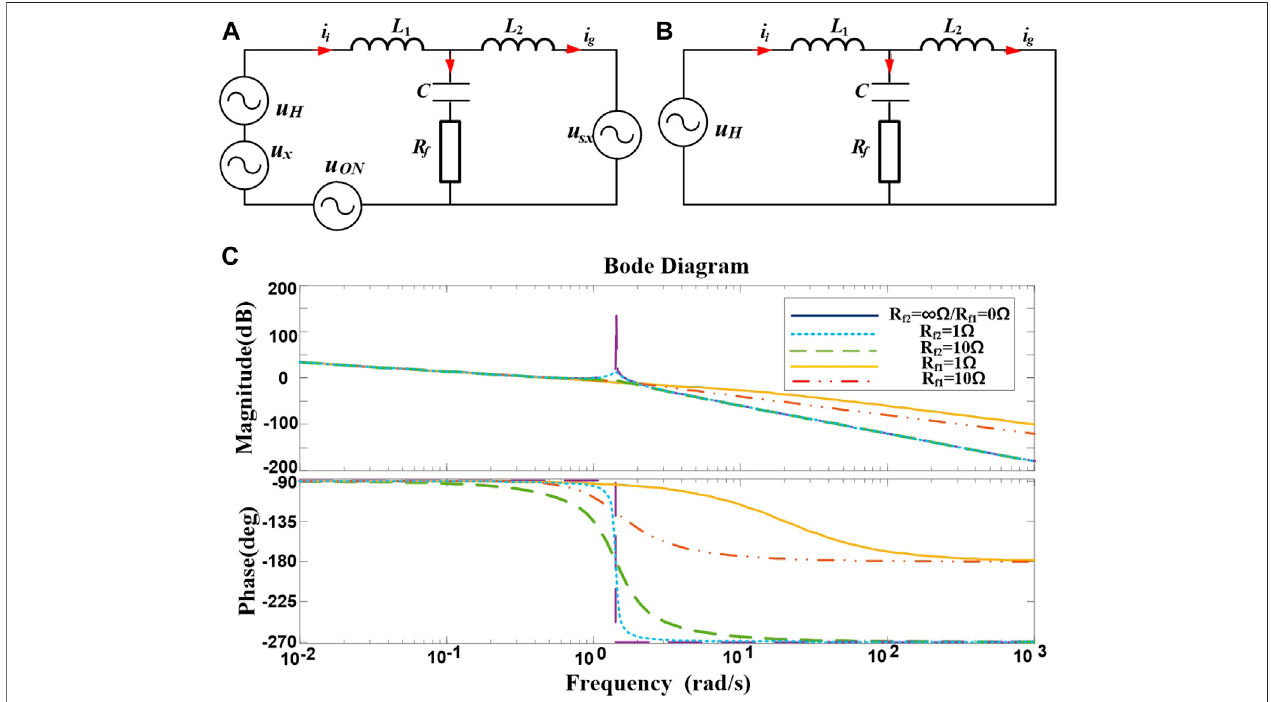
FIGURE 2 | Equivalent model and Bode diagram of the LCL fi lter. (A) Basic equivalent model of series resistance. (B) High-frequency equivalent model of series resistance. (C) Bode diagram of LCL fi lter with series ( R f 1 ) or parallel resistor ( R f 2 ) on the